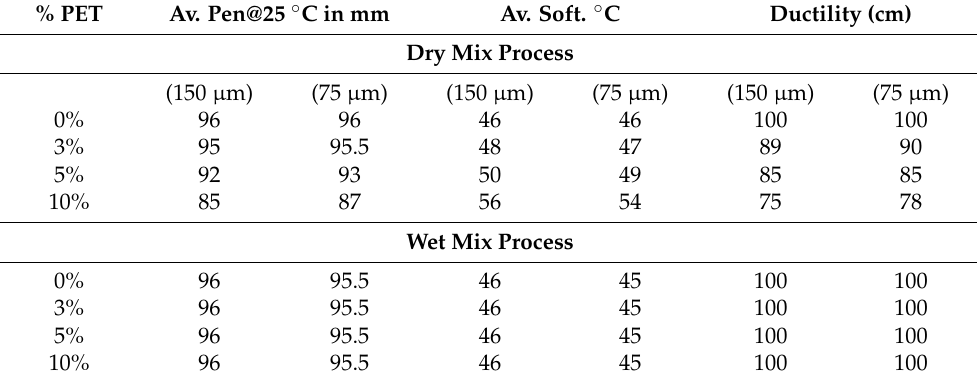
Table 4. Effect of mixing process on physical properties of asphalt binder.